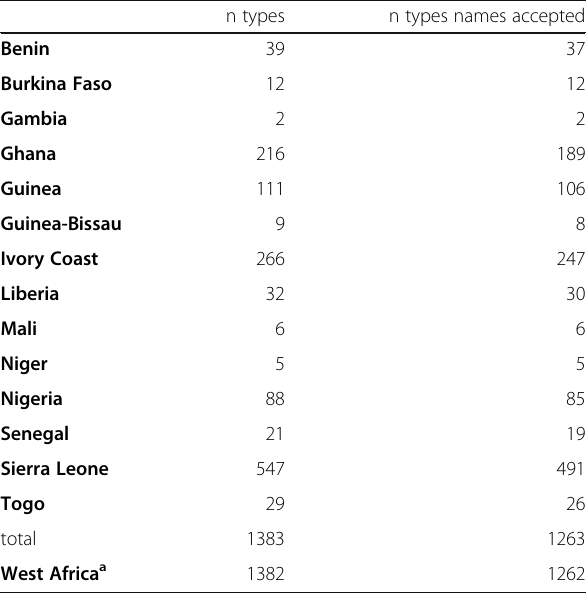
Table 3 The number (n) of types for species or infraspecific taxa originating from West African countries and West Africa. Most of the names are accepted as basionym or as homotypic